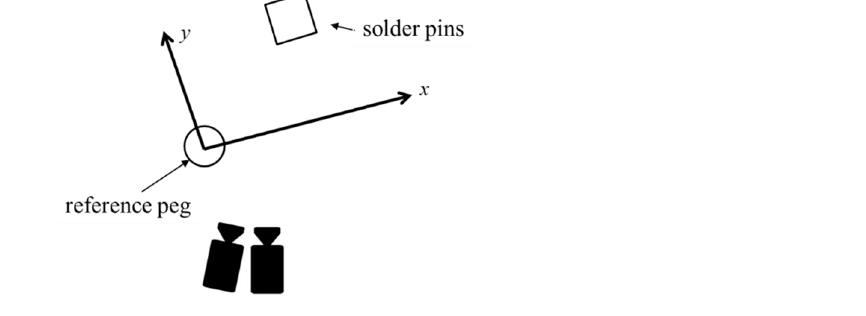
Figure 3. Using two cameras oriented in different directions to capture the pin position from the side of a connector.